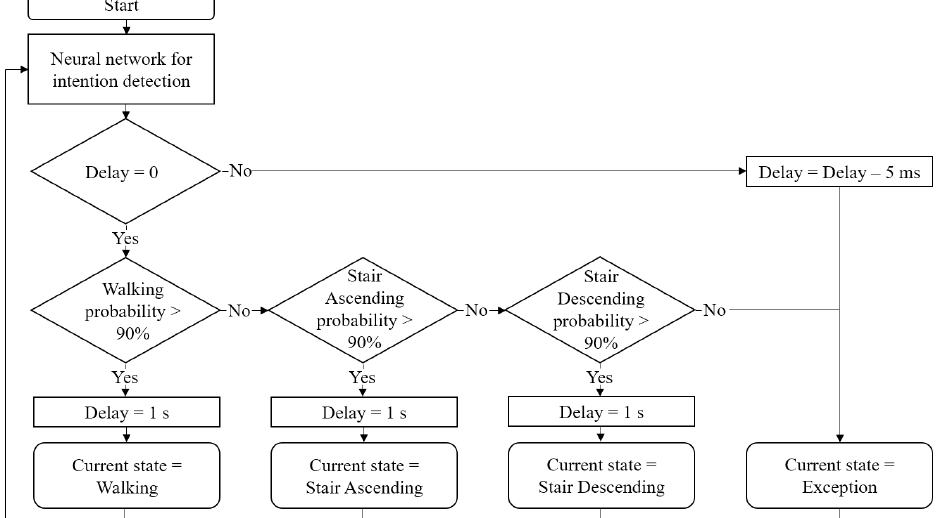
Figure 9. State decision algorithm. If the neural network output probability of any state exceeds 90% and the current state has not changed in the past 1 s, the state is determined as the current state.